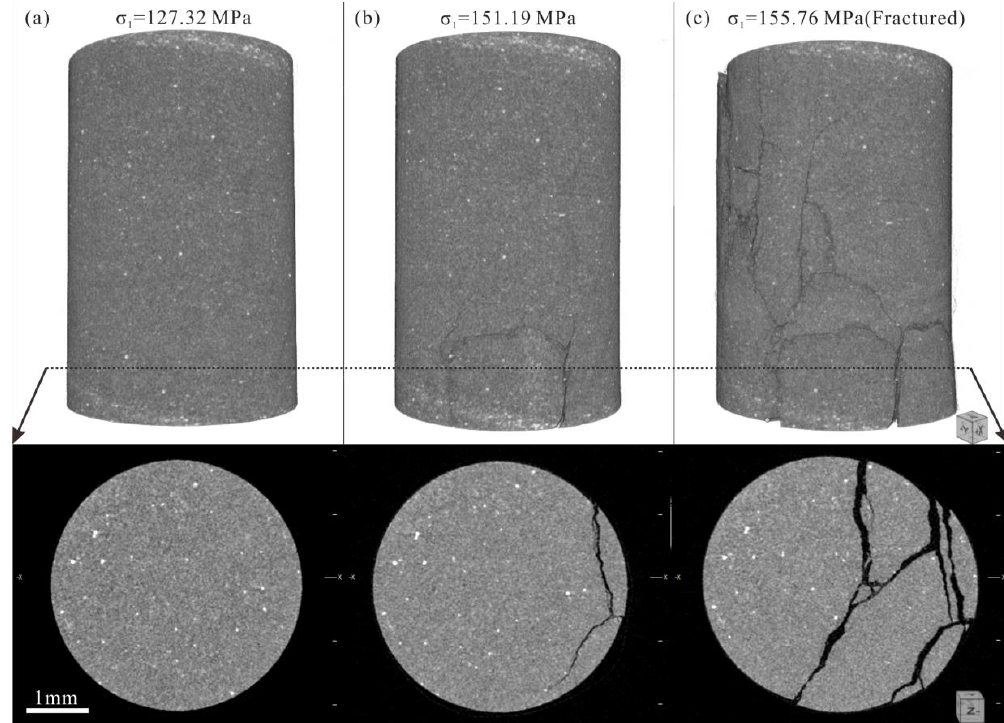
Figure 11. Specimen SZB4 at different load stages. ( a ) σ 1 = 127.32 MPa; ( b ) σ 1 = 151.19 MPa; ( c ) Fractured specimen (after σ 1 = 155.76 MPa).